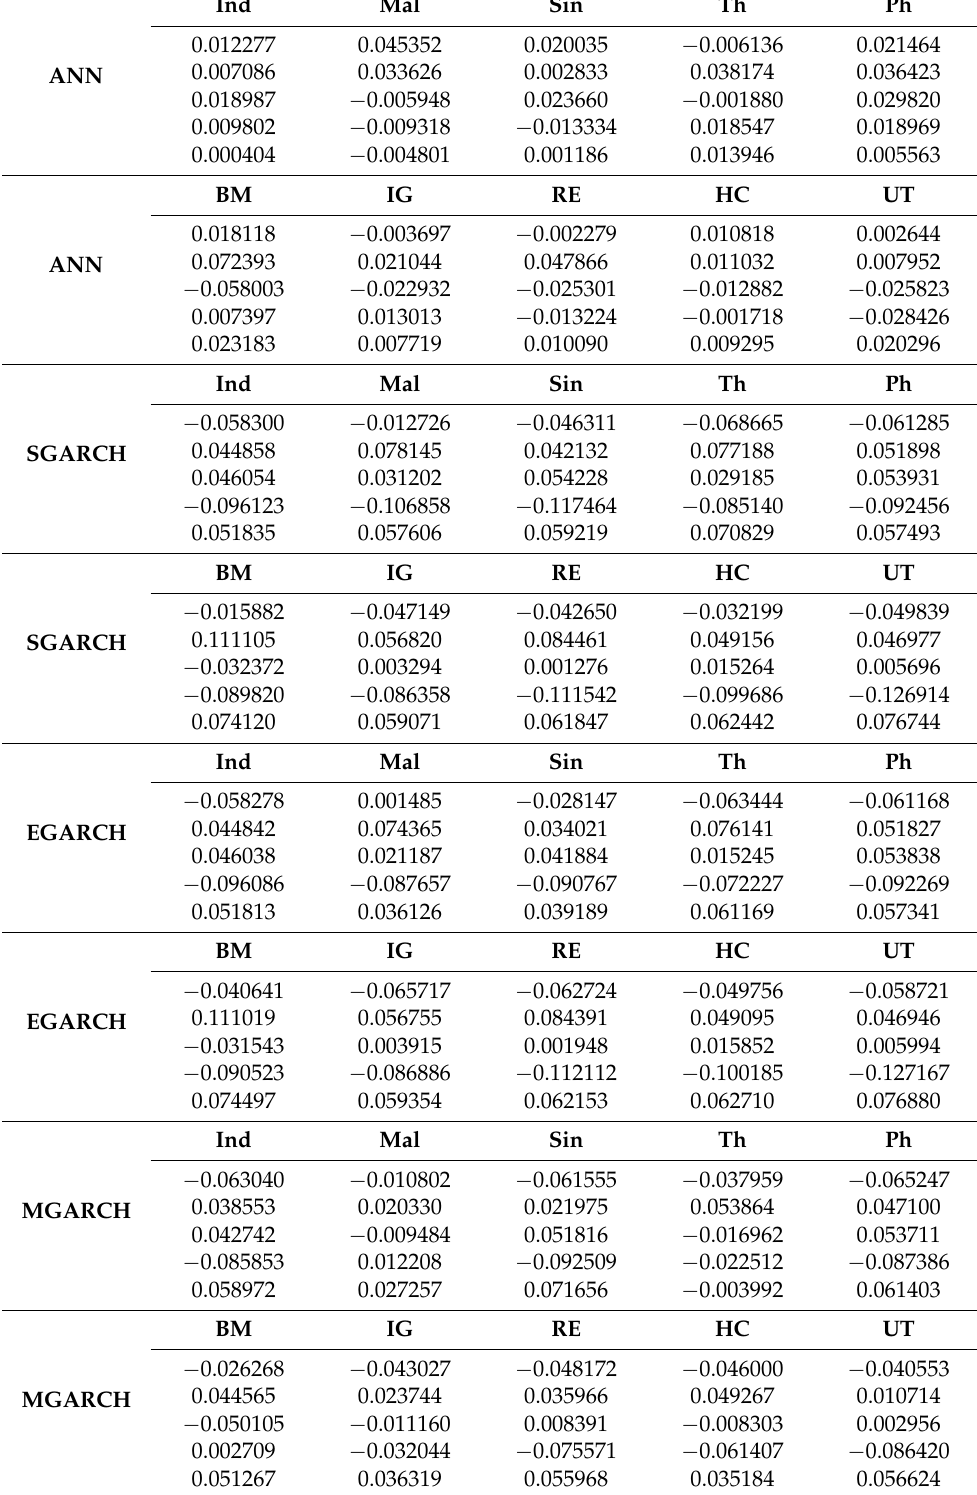
Table A5. Time-Varying Expected Returns less Actual Returns (five-steps ahead forecast). Results are in ascending order week one (top) through week five